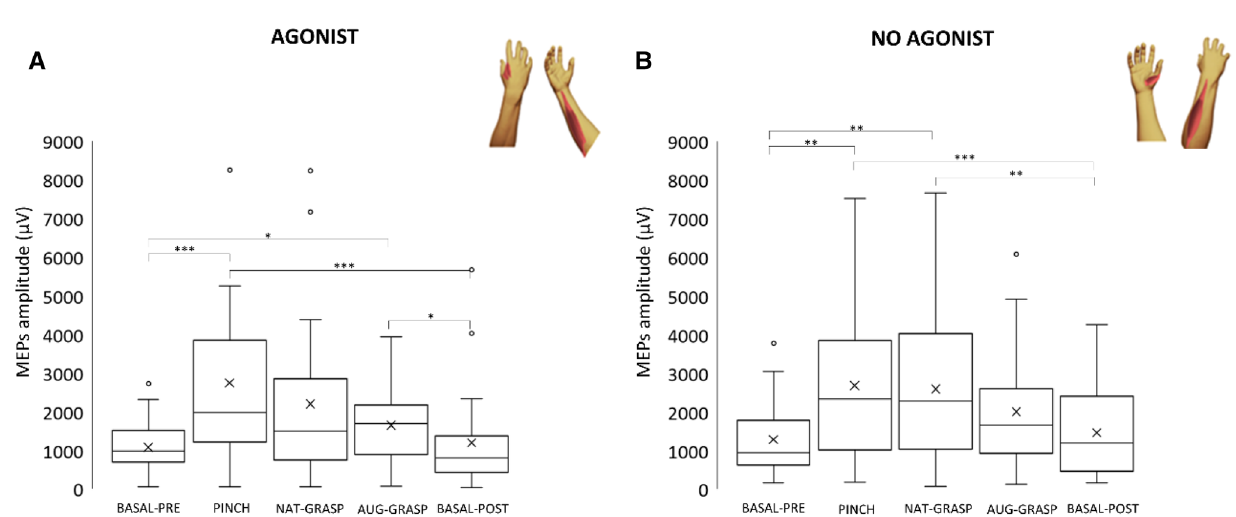
Figure 5. Agonist (FDS + FDI) versus non-agonist (EDC + APB) muscles MEPs amplitude. ( A ) Agonist muscles MEPs amplitude variation versus resting condition (BASAL-PRE); ( B ) Non-agonist muscles MEPs amplitude variation versus resting condition (BASAL-PRE). Same organization as previous